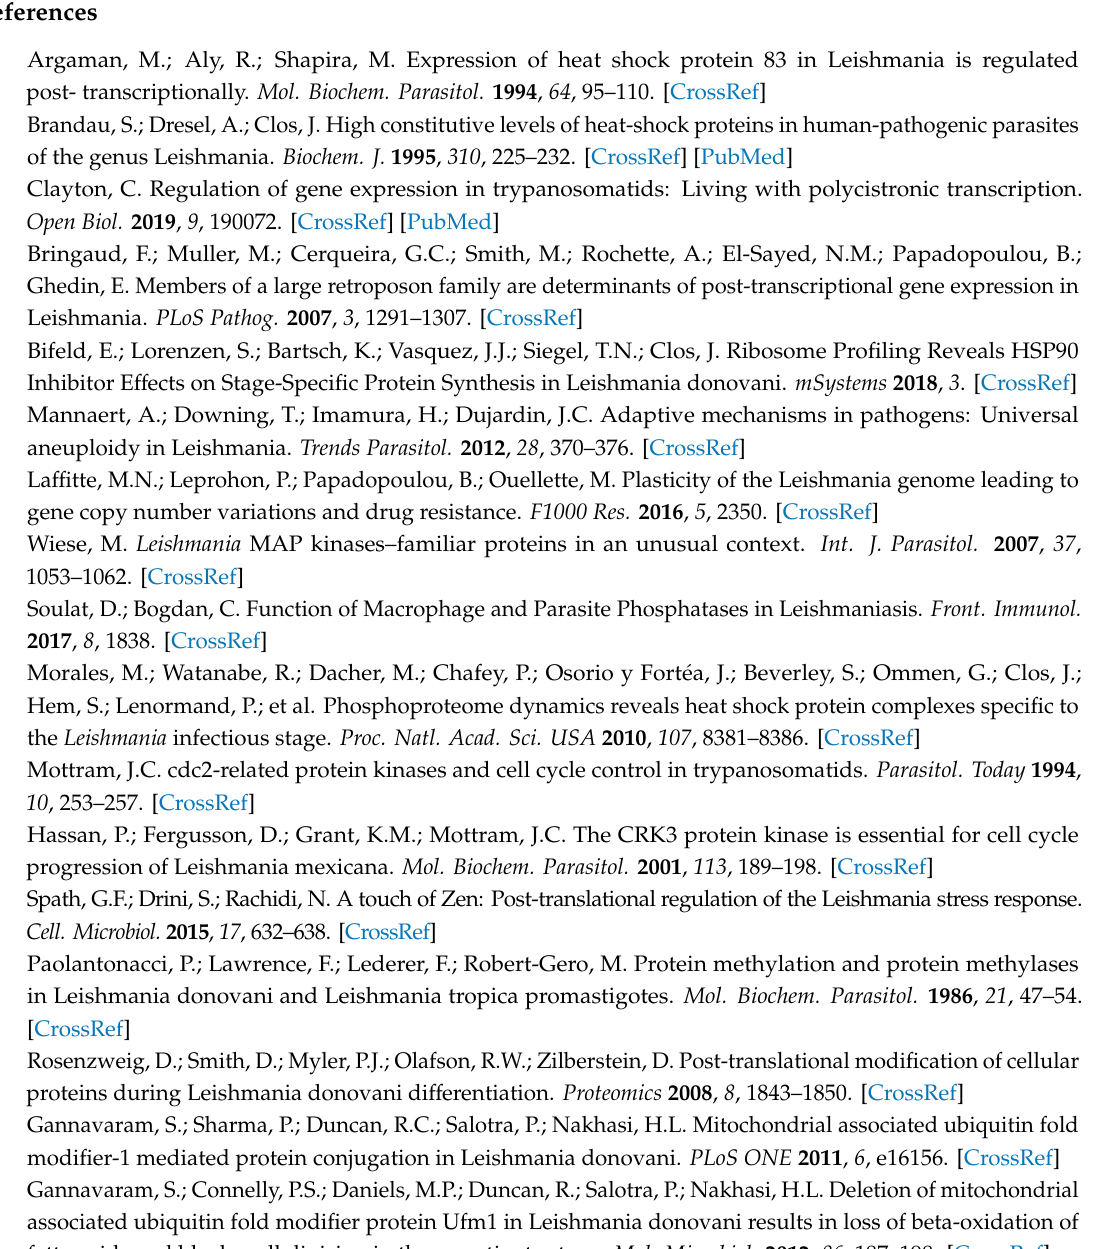
Table S1: Oligonucleotides used for targeting constructs; Table S2. Primers used for RT-qPCR and PCR; and Figure S1: Images of original Western blot and Coomassie Brilliant Blue-stained PA